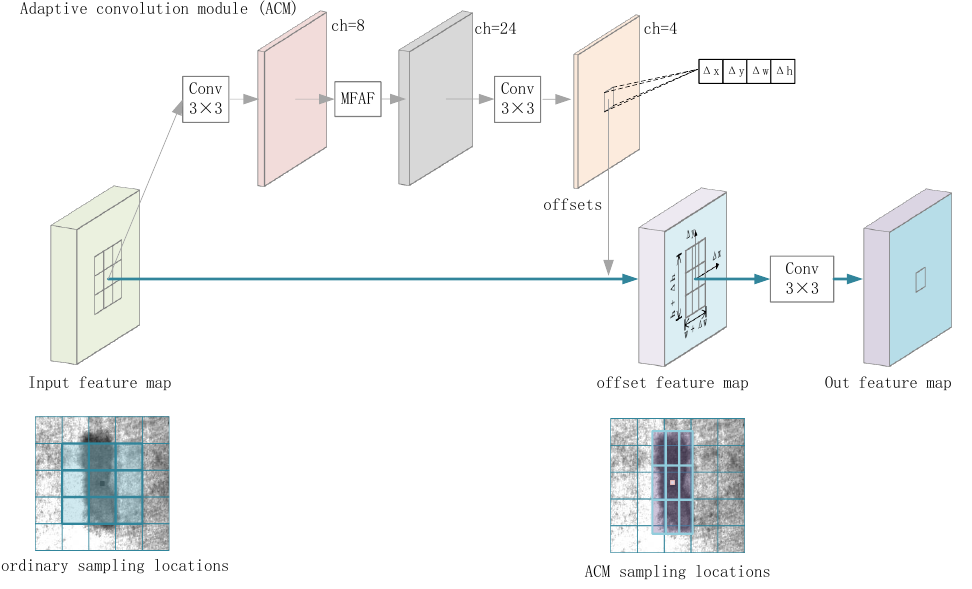
Figure 4. Adaptive convolution module